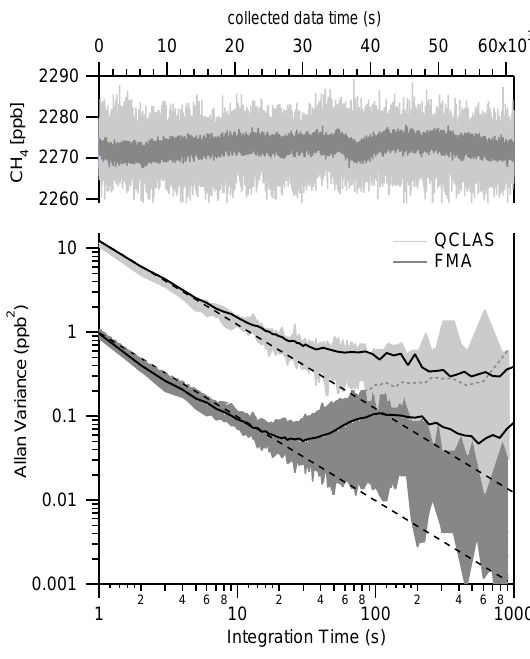
Fig. 2. Precision and stability over time of both analyzers quanti- fied by the Allan variance technique. The top part shows the CH 4 mixing ratio measured over 16h by the two analyzers from a pres- surized air cylinder. Data from the QCLAS are shown in light gray, those from the FMA are in dark gray. The bottom part is the log-log plot of the sample variance as a function of the averaging time. The dashed line indicates the white-noise behavior, while the black line is the variance associated to the long-term measurement. The time series was also split into 30min sequences and all individual Allan variance plots were calculated. The filled areas thus represent the envelope of all individual 30min Allan variance plots, indicating the range that typical 30min Allan variances would fall